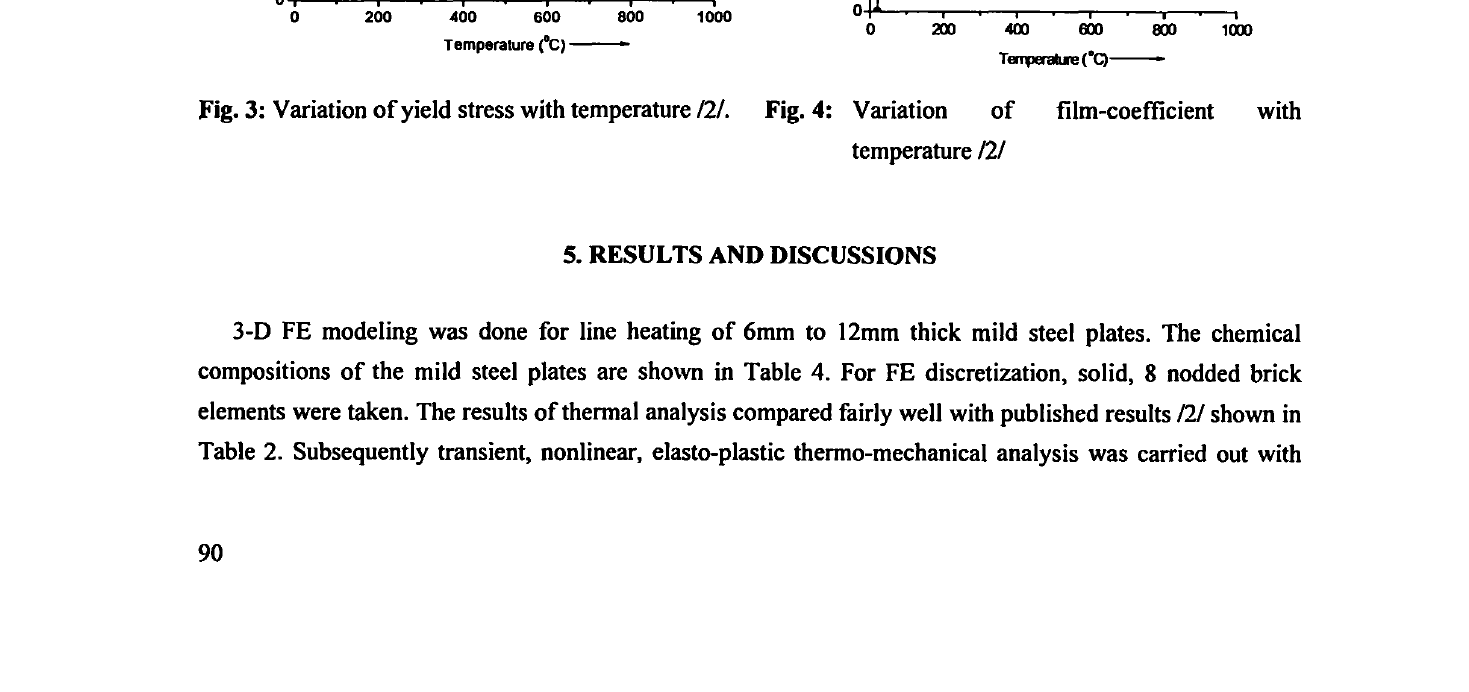
Fig. 3: Variation of yield stress with temperature 121. Fig. 4: Variation of film-coefficient with